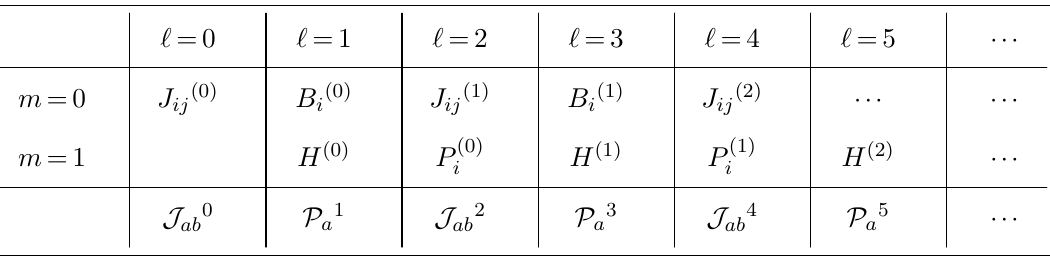
Table 4 . The generators named as in [22] in the (cid:12)rst two rows. The generators of the a(cid:14)ne algebra are given in the last row, where the superscript is just the level ‘ , and decomposes into those in the rows above under the so ( D (cid:0) 1) subalgebra of so (1 ; D (cid:0)